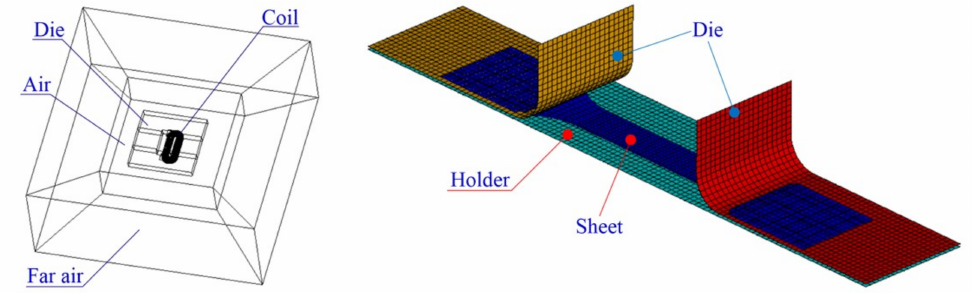
Figure 2. Finite-element models for magnetic pulse forming: ( a ) electromagnetic field model and ( b ) structure